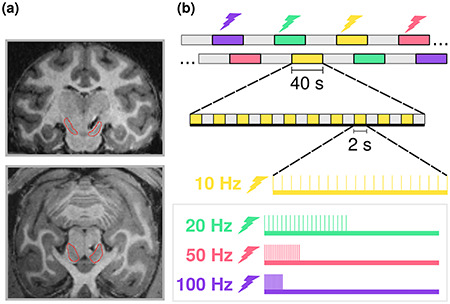
(a) Coronal and transverse slices of a post-operative T1-weighted anatomical scan of Monkey T. Black distortion indicates the position of the chronic electrode relative to the Substantia Nigra, indicated by the red outline. (b) Overview of the fMRI design consisting of alternating blocks of 40 seconds of stimulation (10 Hz, yellow; 20 Hz, green; 50 Hz, red; 100 Hz, purple) and baseline (no stimulation, gray). Each of the stimulation blocks consisted of 10 equally-spaced stimulation trains of the same frequency.